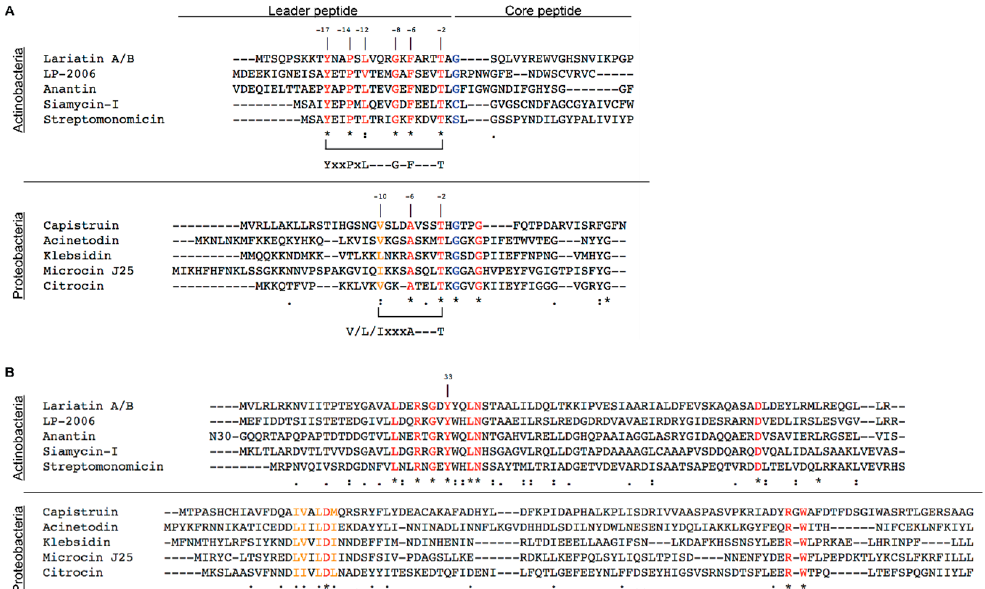
Figure 4. Lasso peptides produced by Actinobacteria or Proteobacteria are di ff erent. ( A ) Sequence alignment of the precursor peptides. Lasso peptides produced by Actinobacteria and Proteobacteria di ff er in their leader peptide. A YxxPxL motif is found in all lasso peptides produced by Actinobacteria whereas those produced by Proteobacteria have a conserved I / V / LxxxA motif. A threonine found two positions upstream of the start of the core peptide is highly conserved in all lasso peptides. ( B ) Sequence alignment of the B1 proteins in actinobacteria and the B proteins in Proteobacteria. No similarities are seen between the two di ff erent phyla that produce lasso peptides. N30 represents 30 amino acids not shown in the sequence alignment. Highly conserved residues are highlighted in red; similar residues are highlighted in orange; the start of the core peptide is highlighted in blue. Sequences of each precursor peptide and their respective B protein were accessed through GenBank: lariatin A / B [38], BAL72548.1; LP2006 [24], AFR05970.1; anantin [24], WP_107057732.1; siamycin-I